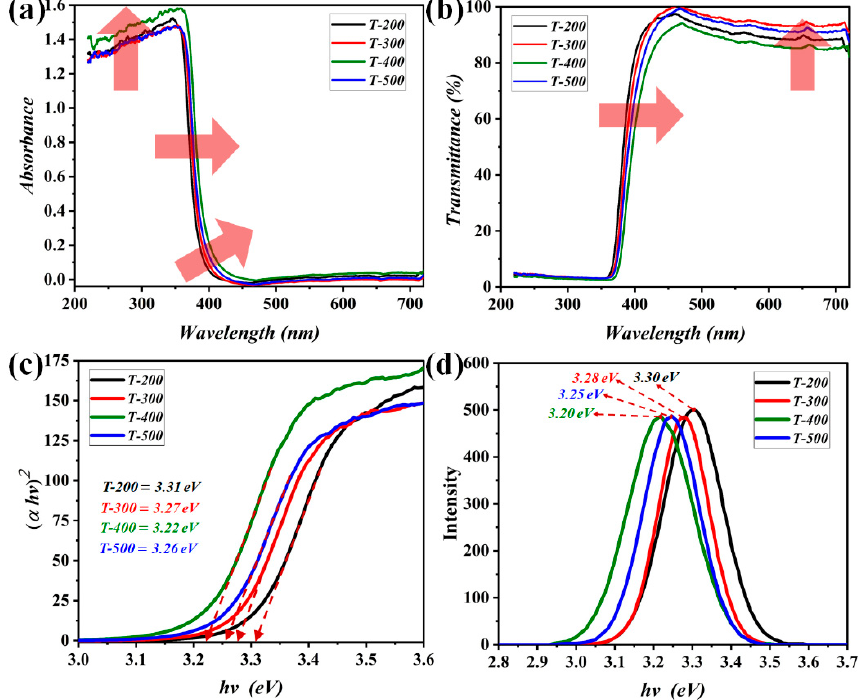
Figure 4. Optical validation for ( a ) absorbance, ( b ) transmittance (%), ( c ) energy bandgap, and ( d ) PL spectra of the deposited films.